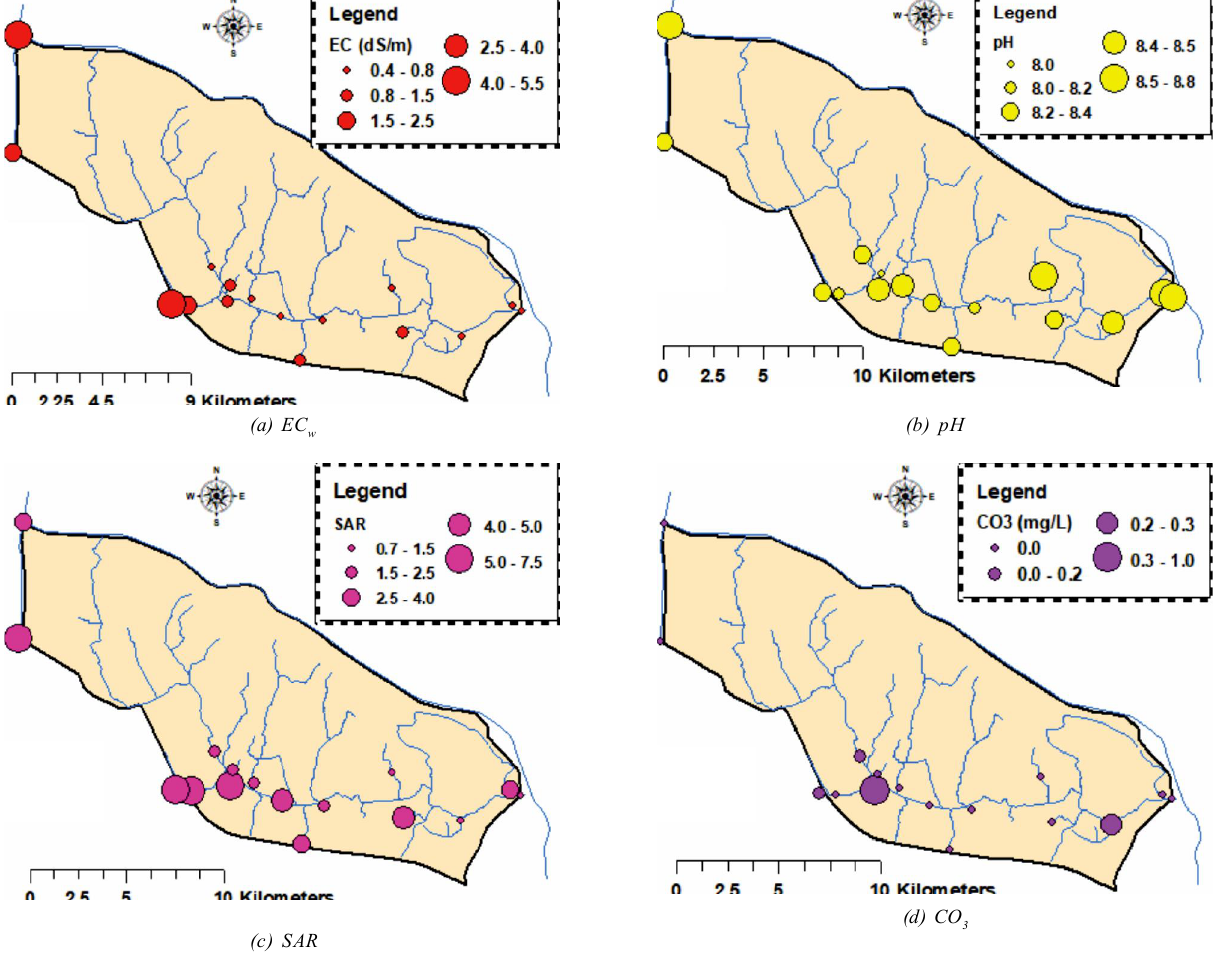
FIG. 4. THEMATIC MAP FOR EC